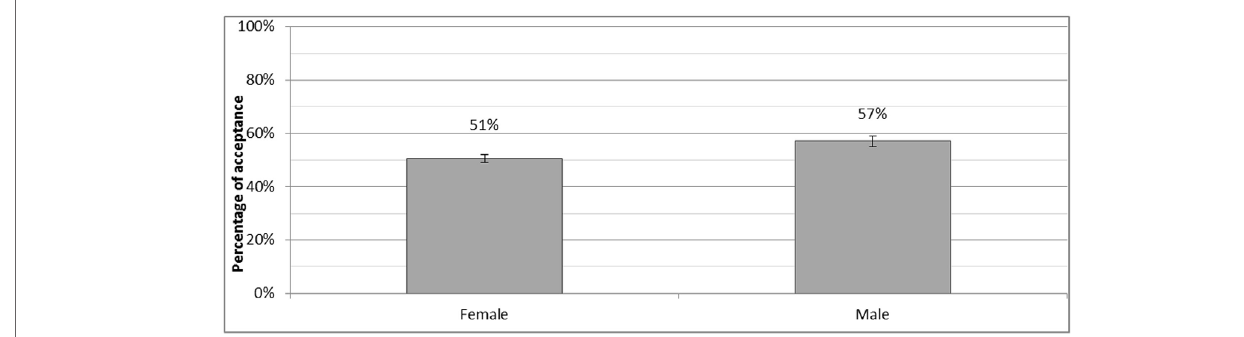
FigUre 1 | Rates of cleft acceptance as a function of gender.